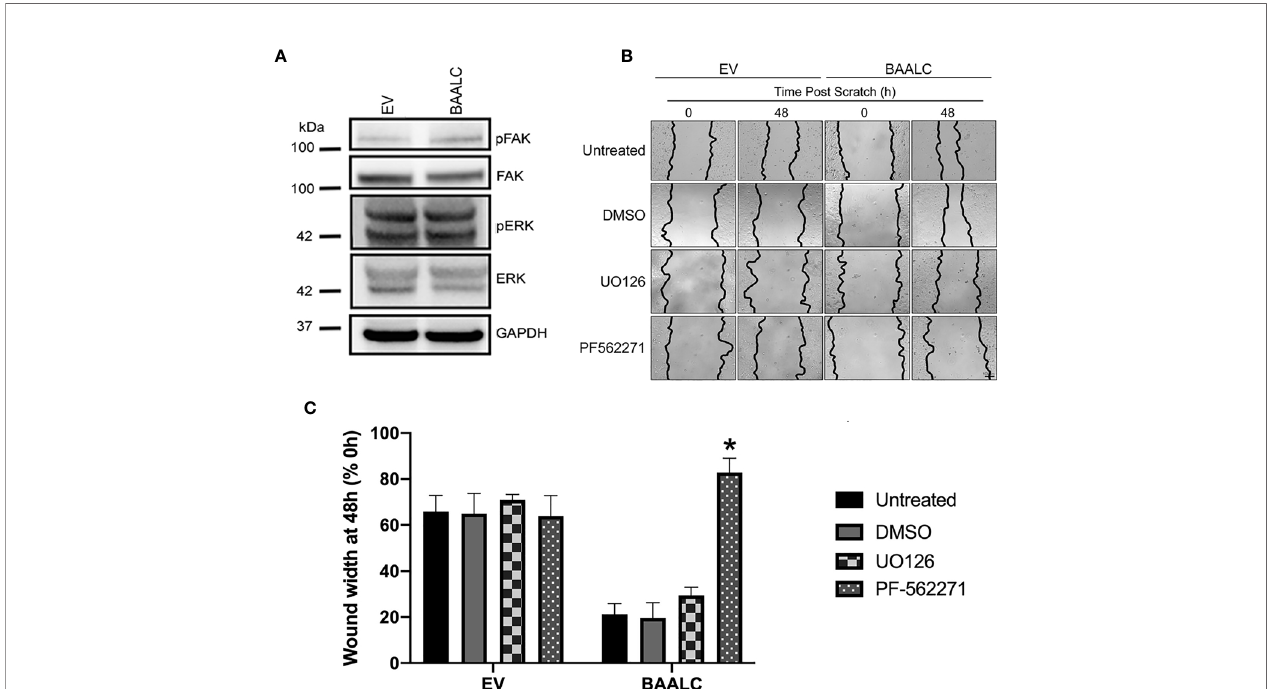
FIGURE 6 | FAK, but not ERK, inhibition decreases BAALC-mediated MCF-7 migration in vitro . MCF-7 cells stably transfected with an empty vector (EV) or BAALC were generated. (A) The expression and phosphorylation of FAK and ERK following BAALC overexpression were measured by western blot in MCF-7-EV and BAALC cells. Blots are representative of three independent experiments. (B) Con fl uent monolayers of MCF-7-EV and BAALC cells were grown to con fl uence, treated for 1 h with either serum-free media (untreated), vehicle, UO126 or PF-562271, and a wound was made by scratching with a pipette tip. The wounds were photographed at 0 and 48 h to measure wound closure. Photomicrographs are indicative of 4 independent experiments performed in triplicate. (C) Wound widths are expressed as % of 0 h wound width. * denotes statistical signi fi cance (p < 0.05).